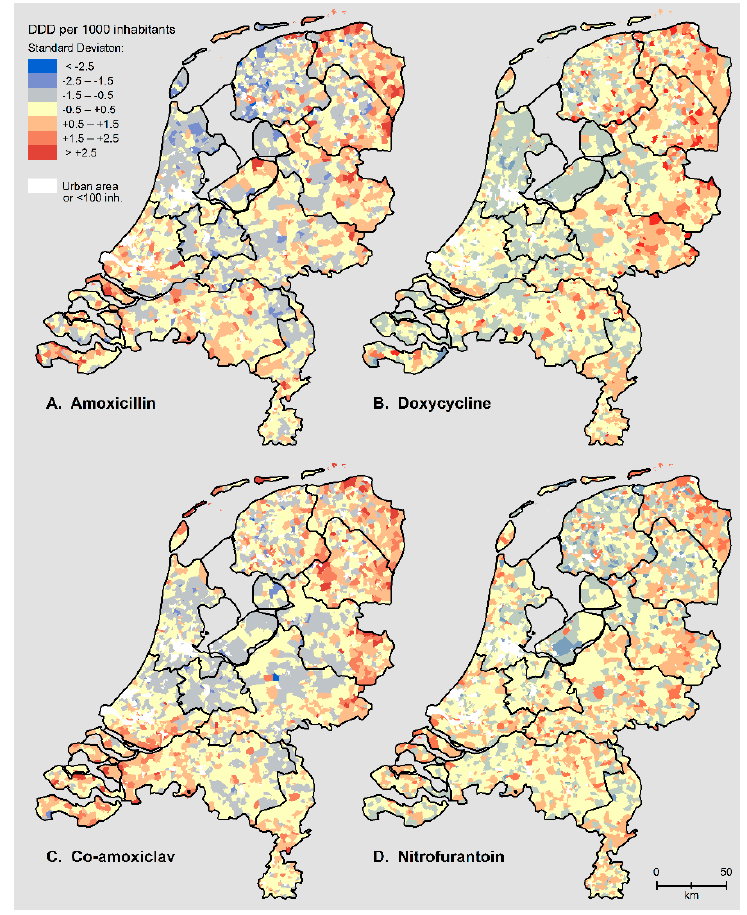
Figure 1. Antibiotic use (DDD per 1000 inhabitants) per 4-position Postal Code area ( n = 2586) in the Netherlands in 2015 as the number of standard deviations from the mean. ( A ) Amoxicillin; ( B ) doxycycline; ( C ) co-amoxiclav; ( D ) nitrofurantoin. Urban areas and areas with fewer than 100 inhabitants are displayed in white.